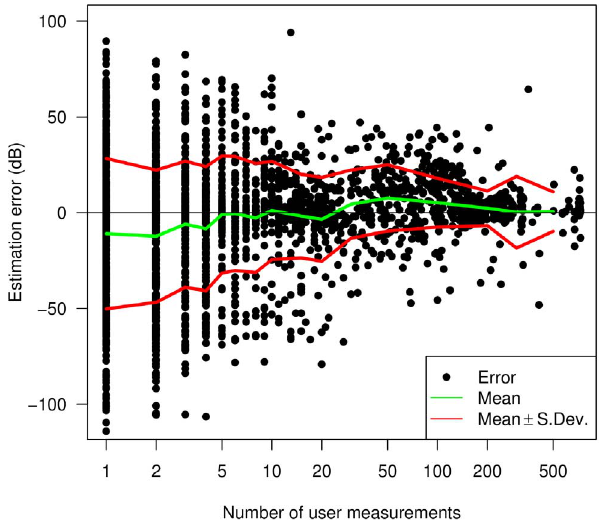
Figure 12. Estimation error. Difference between estimated and real dB value vs the number of measurements a user has performed.